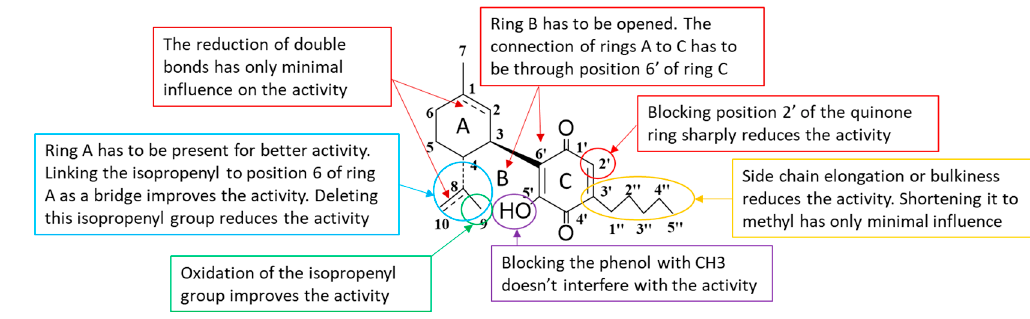
Figure 5. The summary of cannabinoid quinones structure-activity relationship (SAR).